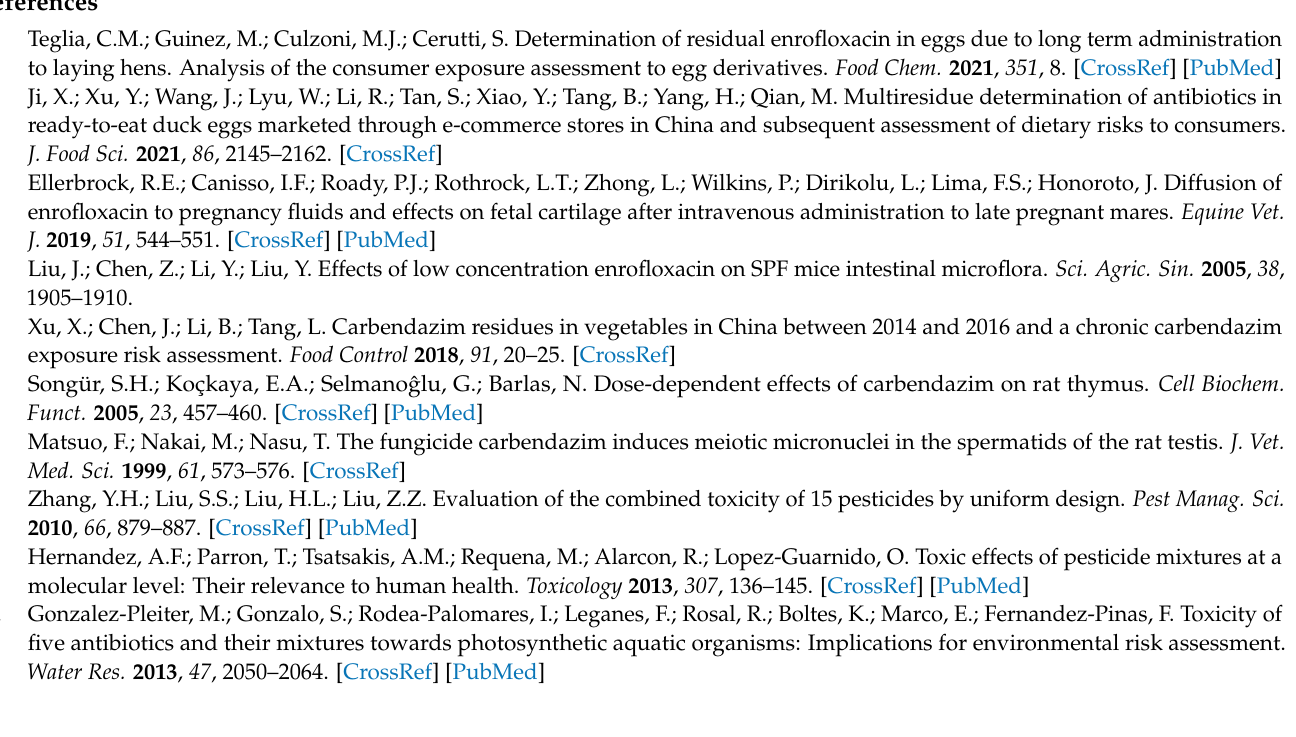
Table S1. Primer pairs of selected genes in qRT-PCR